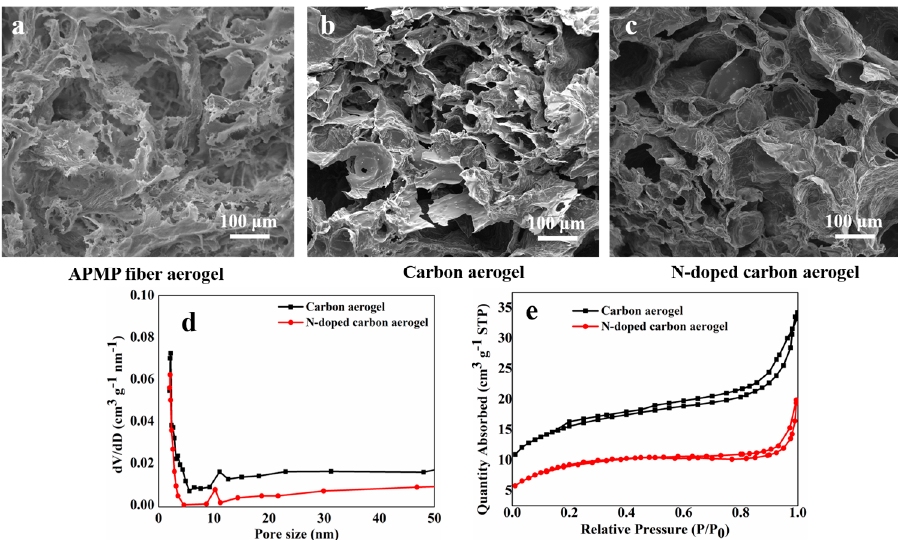
Figure 2. SEM images of ( a ) APMP aerogel; ( b ) carbon aerogel; and ( c ) N-doped carbon aerogel; ( d ) N 2 adsorption-desorption isotherms; and ( e ) pore size distributions of carbon aerogel and N-doped carbon aerogel.